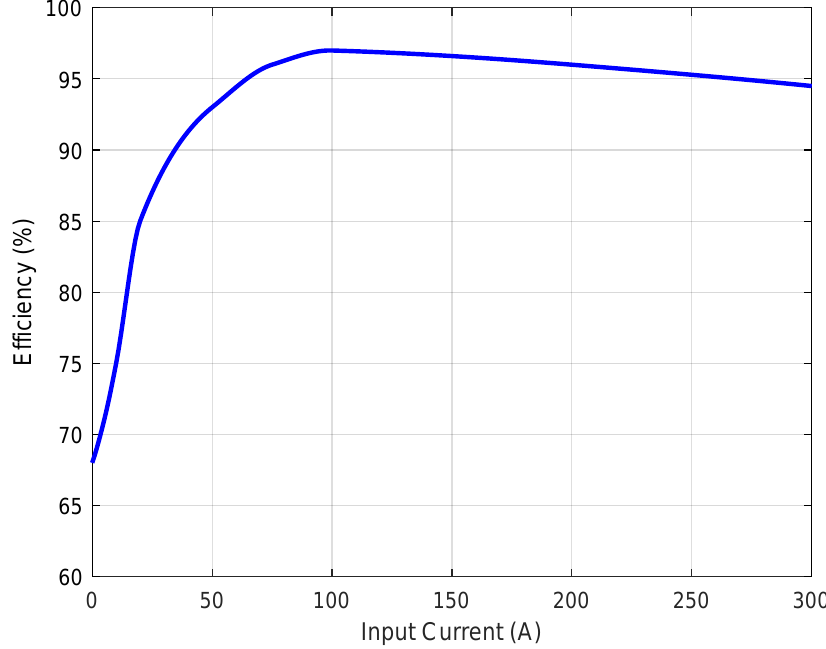
Figure 12. DC-DC efficiency curve as function of the input current. Figure 12. DC–DC efficiency curve as function of the input current.